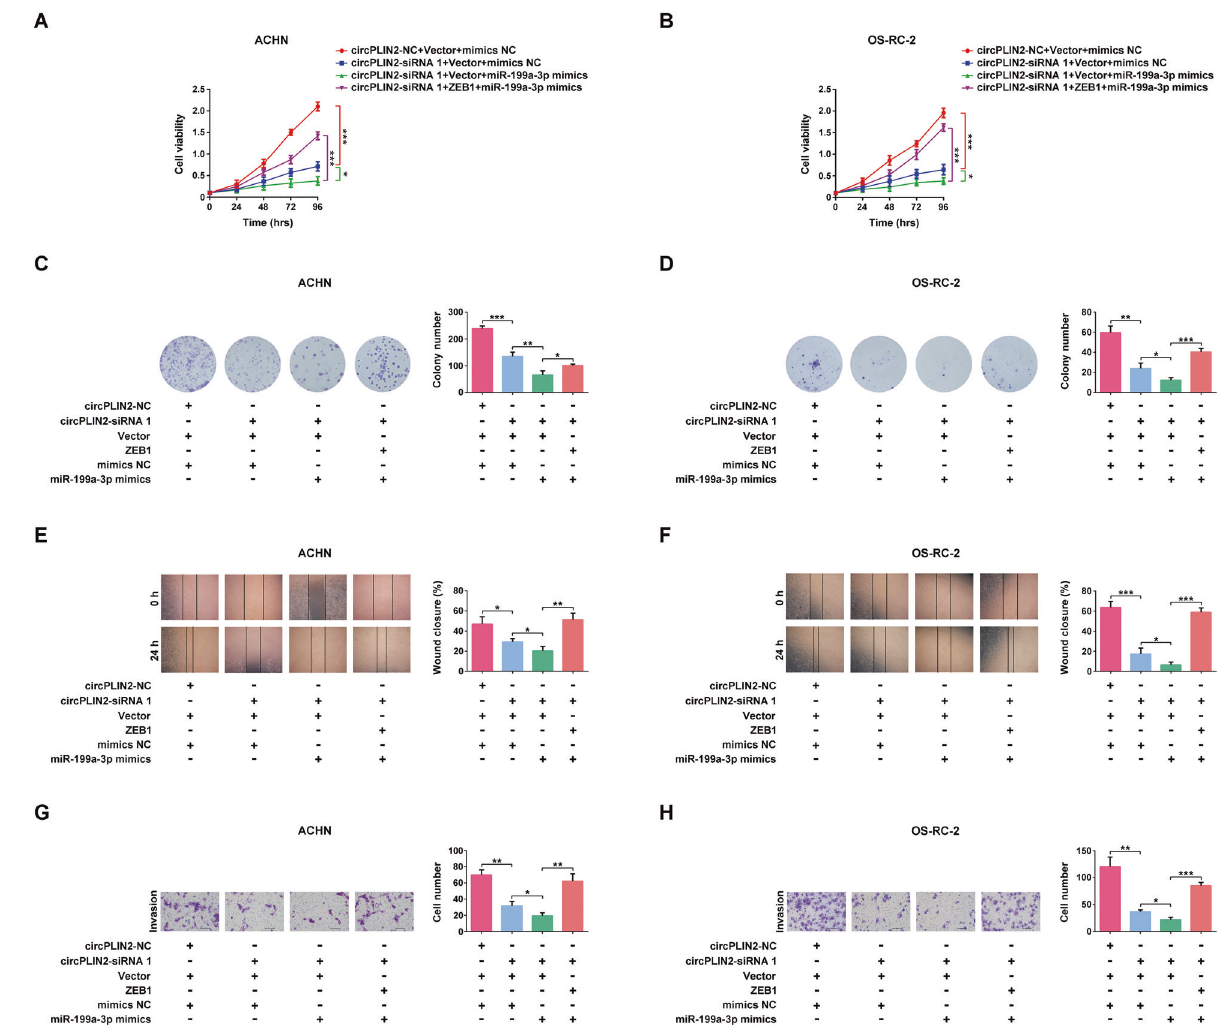
C , D Colony formation assays for ACHN ( C ) and OS-RC-2 ( D ) cells transfected with circPLIN2-siRNA 1 or circPLIN2-NC and ZEB1 or vector and miR-199a-3p mimics or mimics NC. The number of colonies was determined. E , F Wound-healing assays for ACHN ( E ) and OS-RC-2 ( F ) cells transfected with circPLIN2-siRNA 1 or circPLIN2-NC and ZEB1 or vector and miR-199a-3p mimics or mimics NC. The wound closure rate was calculated. Magni fi cation, ×40. G , H Matrigel-coated Transwell assays for ACHN ( G ) and OS-RC-2 ( H ) cells transfected with circPLIN2-siRNA 1 or circPLIN2-NC and ZEB1 or vector and miR-199a-3p mimics or mimics NC. The cell number per fi eld was quanti fi ed. Scale bar, 100 μ m. Two- tailed Student ’ s t test. The error bars represent S.D. * p < 0.05, ** p < 0.01, and ** *p <